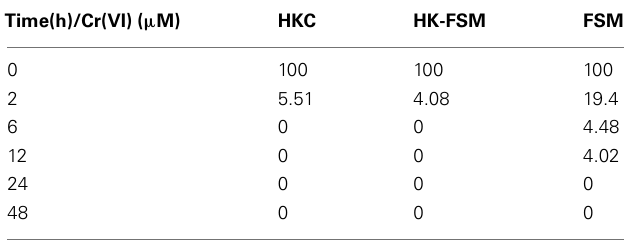
Table 2 | Chromate reduction activity in spent medium of nitrate grown cultures of D. desulfuricans .